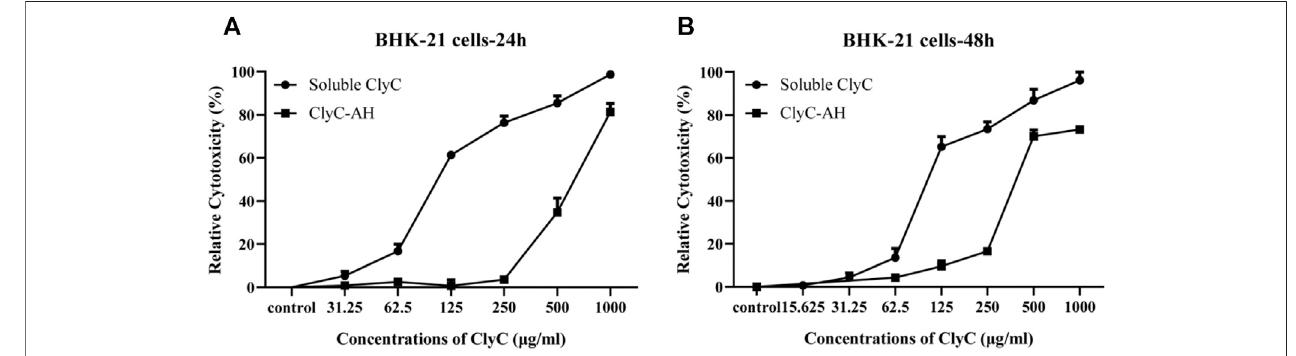
FIGURE 3 | Cytotoxicity of ClyC-AH and free ClyC to BHK-21 cells. Firstly, DMEM incubated with ClyC-AH (0, 31.25, 62.5, 125, 250, 500, and 1,000 µg/ml) for 24 h (A) and48 h (B) .Thencellswereco-culturedwithincubatedDMEManddifferentconcentrationsoffreeClyC(0,15.625,31.25,62.5,125,250,500and1,000 µg/ ml) for 24 h. The relative viability was calculated by the change of OD 450 by CCK-8 assay.